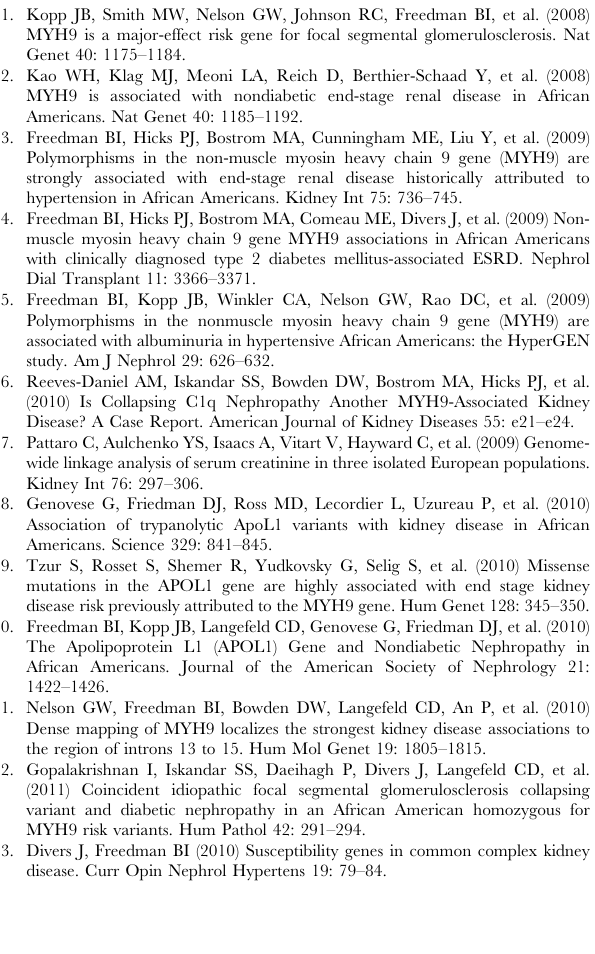
Table S2 Top 100 interactive SNPs, sorted by additive model P- values. Table S3 FRMD3 SNP allele frequencies by MYH9 risk haplotype status (letter in brackets reflects allele). Table S4 FRMD3 SNP allele frequencies by APOL1 risk allele status (letter in brackets reflects